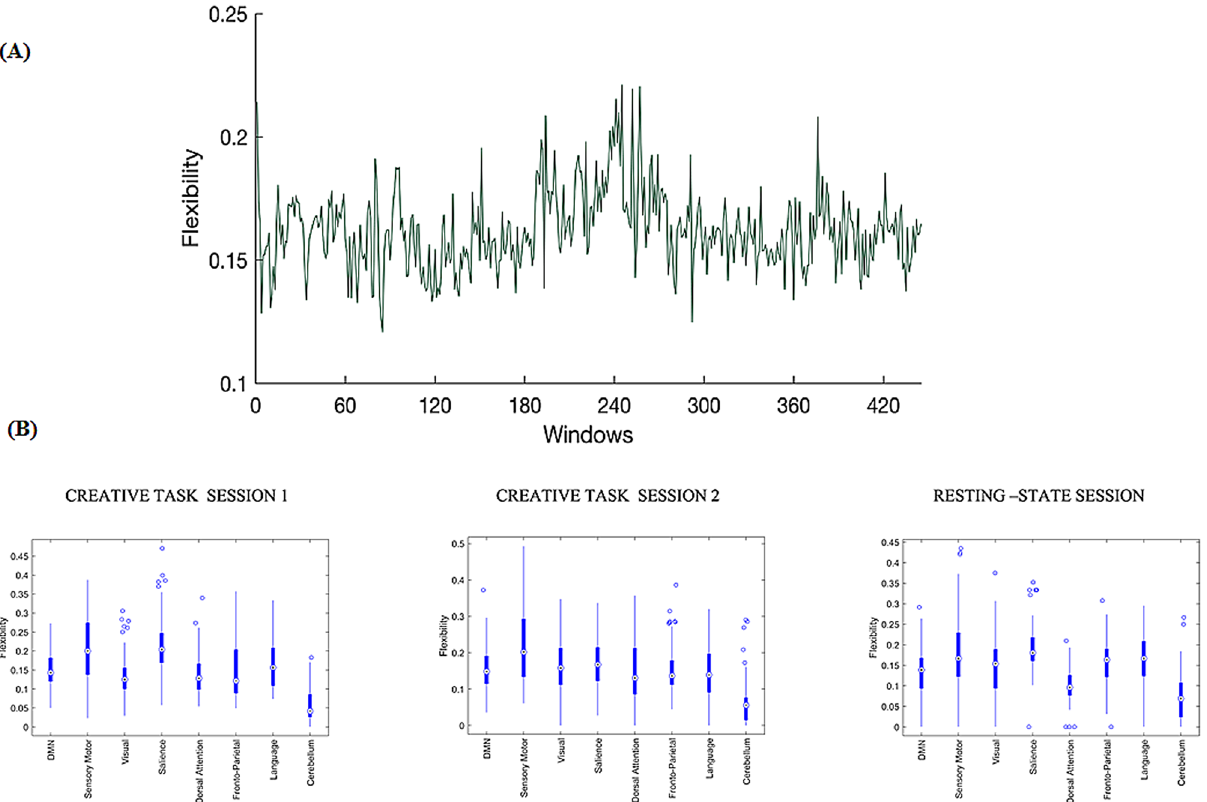
Figure 5. Flexibility of the dynamic brain network associated with creative cognition ( A ) Variation of flexibility across time windows ( B ). Mean flexibility over various networks defined using box plots for creative task session 1, creative task session 2 and resting-state session. Blue circles indicate outliers and blue circles with dots indicate median flexibility value. Uncorrected flexibility values are shown. The networks defined are the default mode network (DMN); sensory/somatomotor network; visual network; salience network; dorsal attention network; fronto-parietal network (FPN); language network; cerebellar